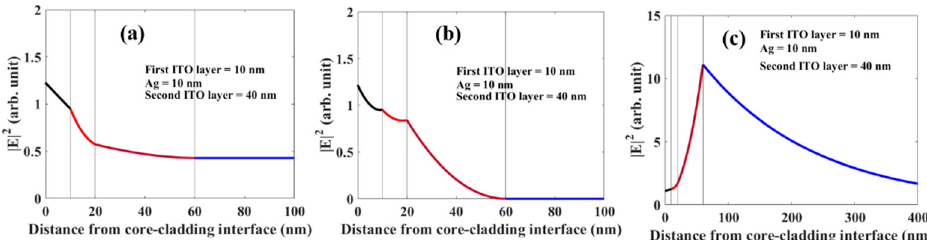
Figure 16. Electric field distribution corresponding to ( a ) first LMR ( b ) second LMR ( c ) SPR at their respective resonance wavelength at 561, 1065, and 1532 nm respectively for probe configuration ITO (10 nm) +Ag (10 nm) +ITO (40 nm).